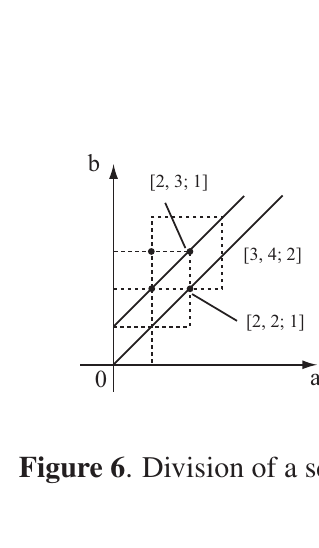
Figure 5 . Covering Ω